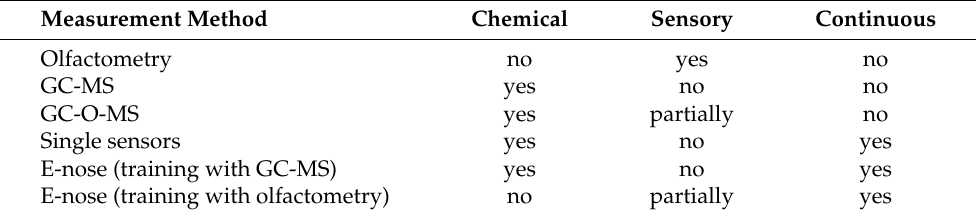
Table 2. Odor measurement methods and their limitations regarding sensory and chemical